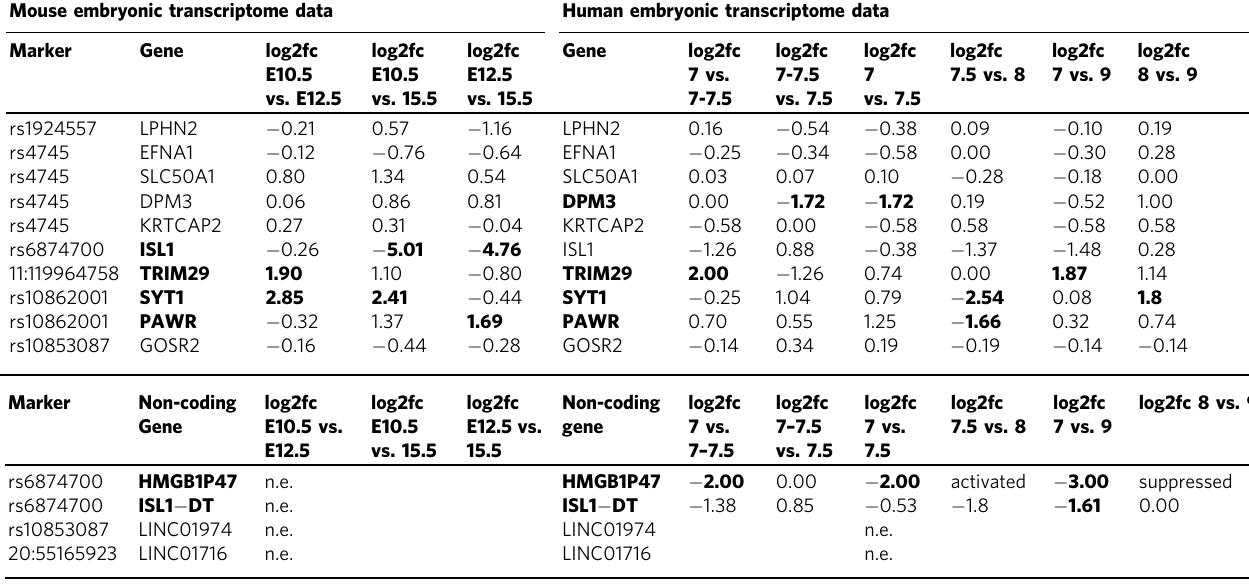
Table 3 RNA expression patterns of coding and non-coding genes in the LD blocks of the most signi fi cant GWAS markers in mouse and human embryonic urogenital